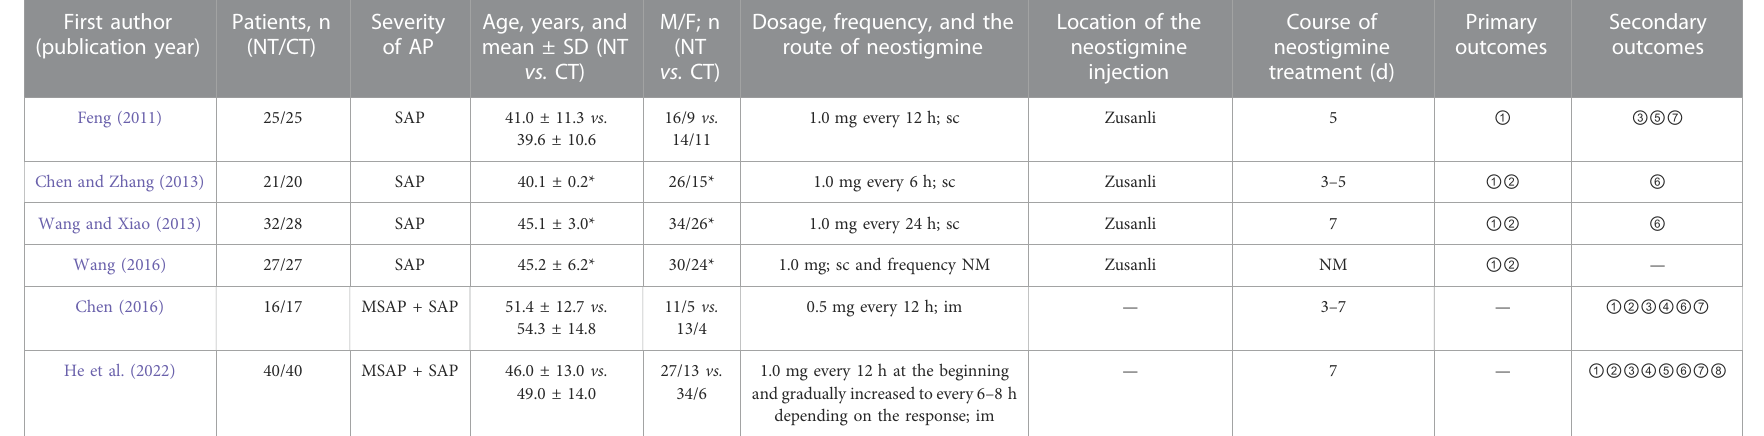
TABLE 1 Characteristics of the included